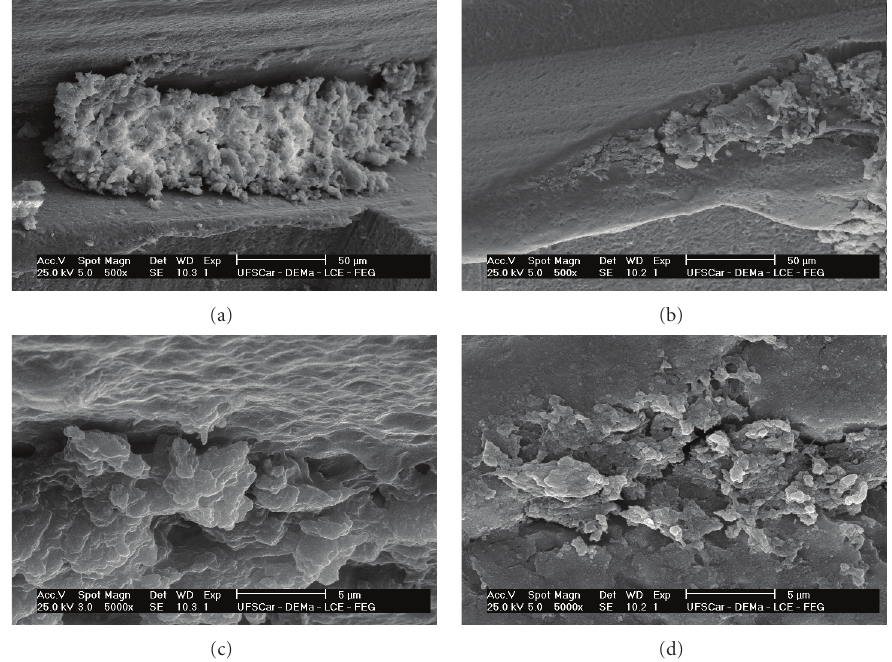
Figure 2: Scanning electron micrographs of retrieved implants for (a) nanoroughened implant surface (control), (b) nanoroughened implant surface + laminin-1 (test) (magnification × 500), (c) higher magnification of the nanoroughened implant surface (control) ( × 5000), and (d) higher magnification of the nanoroughened implant surface + laminin-1 (test) ( ×